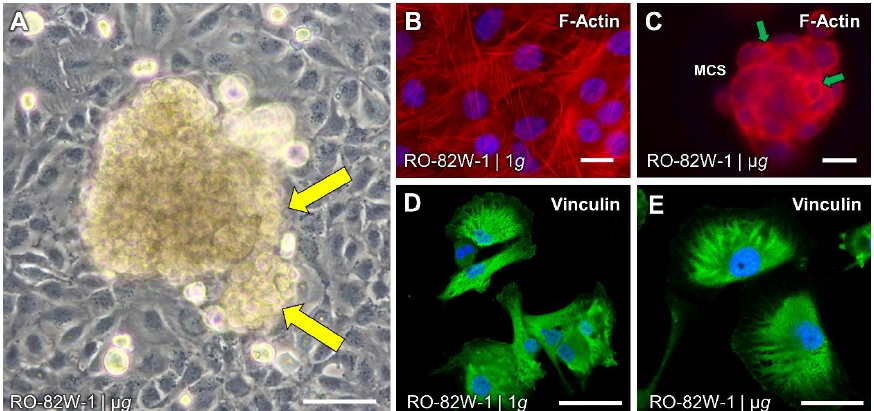
Figure 4. Simulated microgravity affects morphology and growth of thyroid cancer cells: ( A ) Multicellular spheroid (MCS) of UCLA RO-82W-1 cells, observed after three days on a random positioning machine (RPM). Yellow arrows indicate proliferating areas; ( B , C ) Fluorescence staining of F-actin (red) in UCLA RO-82W-1 cells that were grown for three days in normal gravity ( B ) or on an RPM ( C ). Small MCS were visible with increased F-actin deposits at the outer membranes of the MCS surface (green arrows); ( D , E ) Immunofluorescence of vinculin (green) in UCLA RO-82W-1 cells. DAPI-stained nuclei are shown in blue. Scale bars: 50 µm.